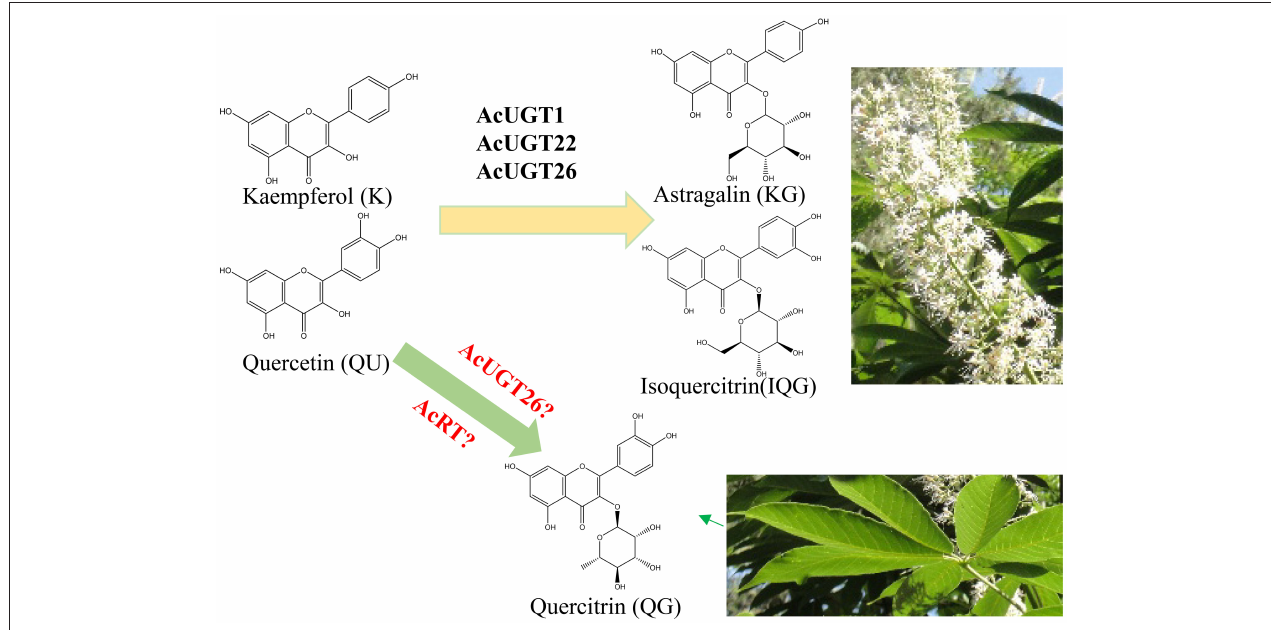
FIGURE 6 | The proposed formation process of astragalin and isoquercitrin in A. chinensis